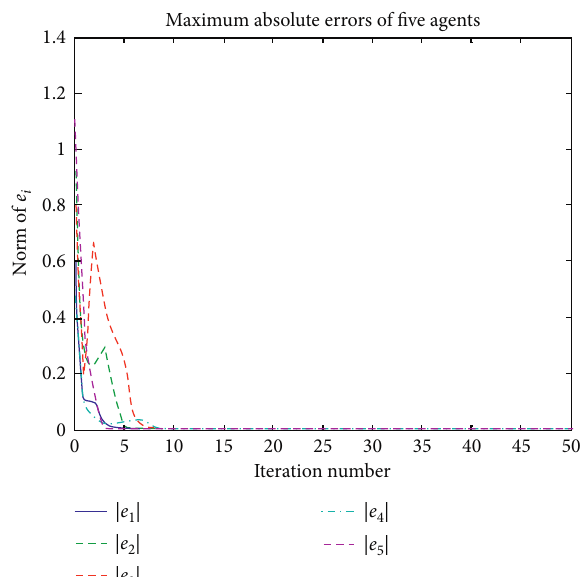
Figure 2: Tracking trajectories of five agents.